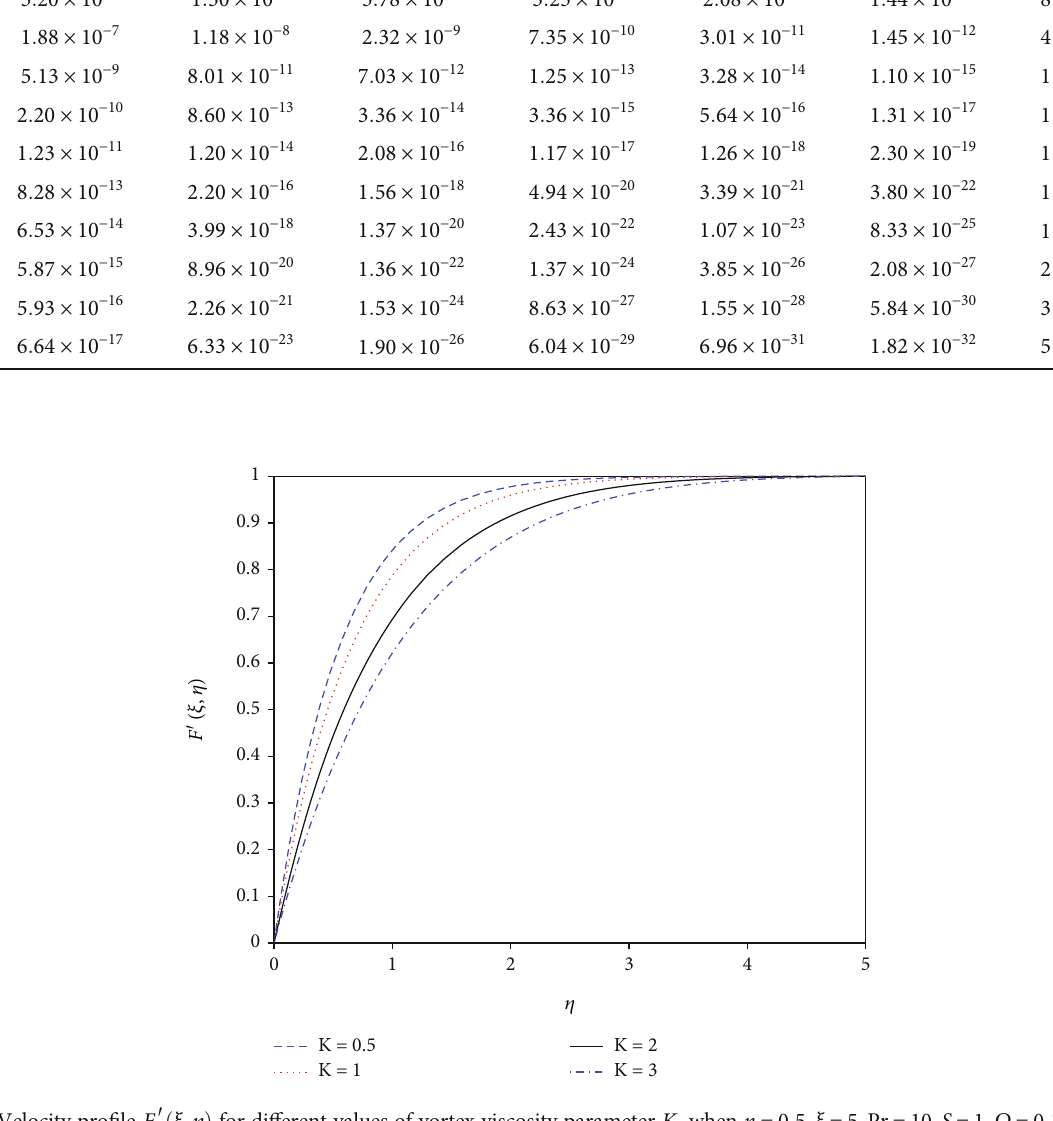
Figure 2: Velocity pro fi le F ′ ð ξ , η Þ for di ff erent values of vortex viscosity parameter K , when n = 0 : 5, ξ = 5, Pr = 10, S = 1, Ω = 0 : 1, N and He = 0 : 2